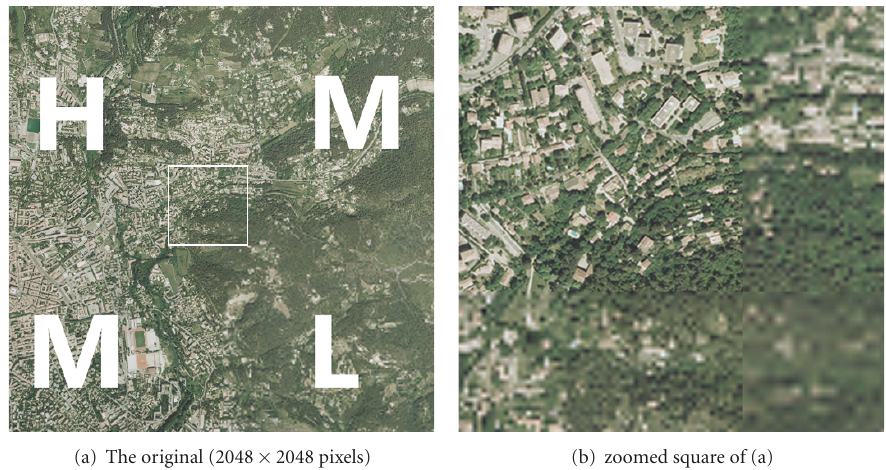
Figure 9: Example texture tessellation: l h = 0, l m = 2, l l = 3.